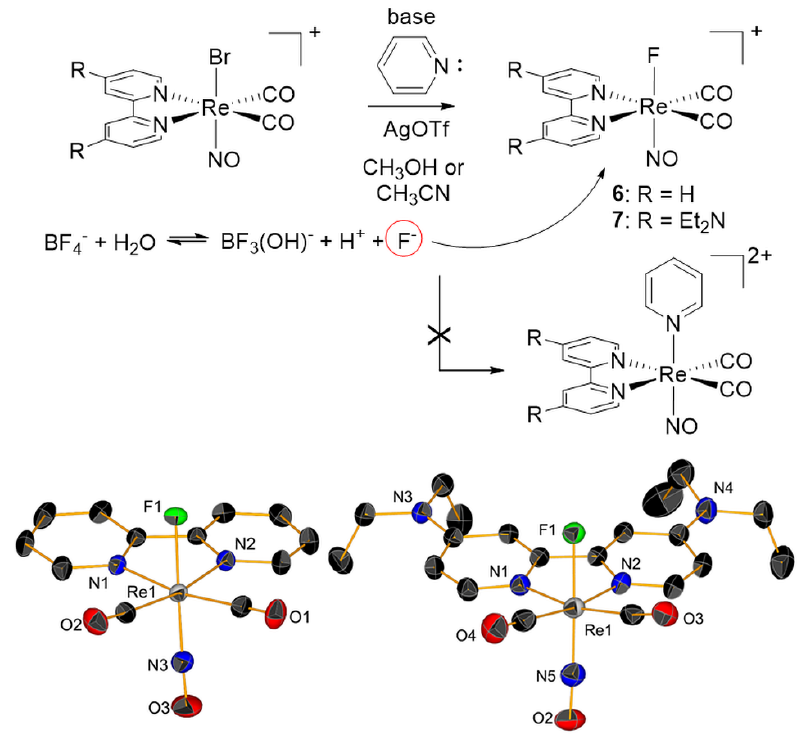
Figure 3. Reaction scheme of attempted synthesis fac -[Re(CO) 2 (NO)(N-N)py] 2+ species from corresponding dicarbonyl-nitrosyl species in the presence of Ag + and py (top) and crystal structure of compound 6 (left) and 7 . Thermal ellipsoids are at 30% probability. Hydrogen atoms and BF 4 − counter ion omitted for clarity. Selected bond lengths (Å): 6 , Re-N1 2.138(4), Re-N2 2.145(4), Re-N3 1.773(6), Re-F 1.970(3), Re-CO 2.020(6) and 1.999(6), C-O 1.108(7) and 1.115(7), N-O 1.159(7); 7 , Re-N1 2.121(3), Re-N2 2.123(4), Re-N5 1.763(4), Re-F 1.984(3), Re-CO 2.017(5) and 1.991(6), C-O 1.123(6) and 1.129(6), N-O 1.185(5). Selected bond angles (°): 6 , O3-N3-Re1 177.3(6); 7 , O2-N5-Re1 176.8(4).